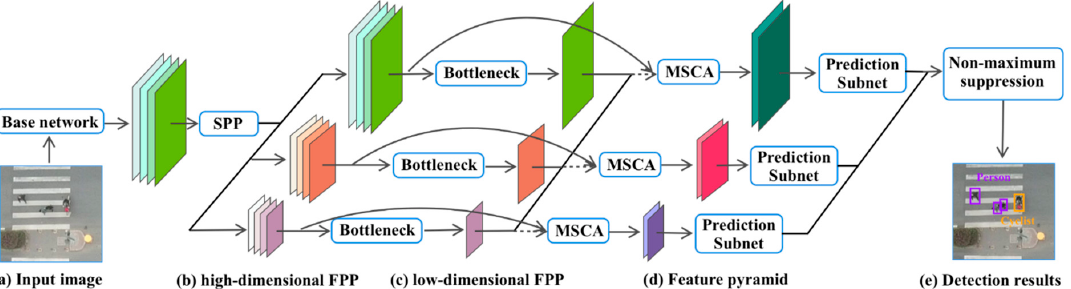
Figure 2. Overview of object detection using the improved PFPNet